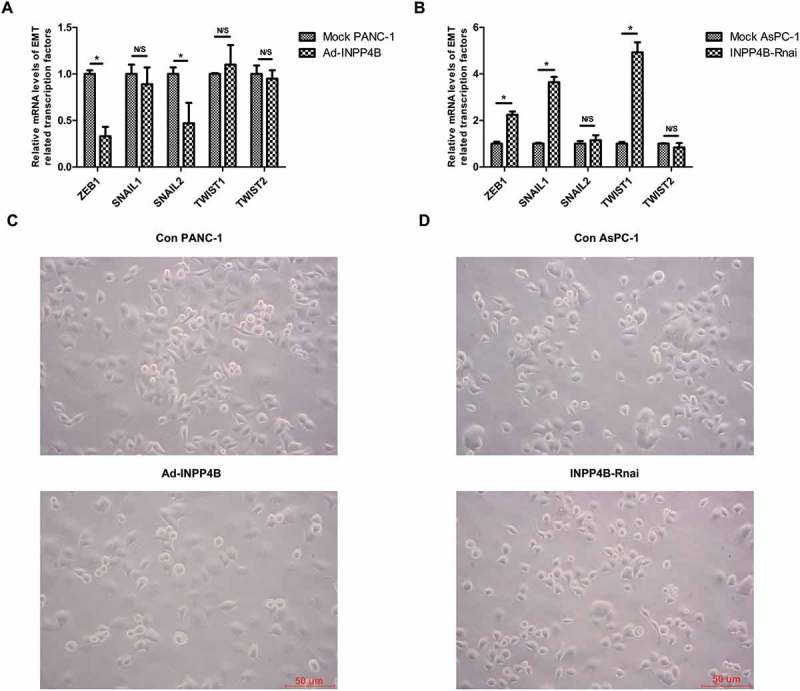
Correlations of INPP4B expression with EMT-associated transcription factors and cell morphology (a) Graph showing relative expression of genes (ZEB1, ZEB2, SNAIL1, SNAIL2 and TWIST) in Ad-INPP4B and INPP4B-Rnai groups compared to that in mock controls. RT-qPCR data analysis was based on 2-△△Ct method and GAPDH was used as housekeeping gene for data normalization. Results show mean ± SD (n = 3). N/S and * indicate P> 0.05 and P < 0.05. (b) Phase contrast images of mock control cells and transduced cells for morphology analysis. Scale bar in images = 50 mm.